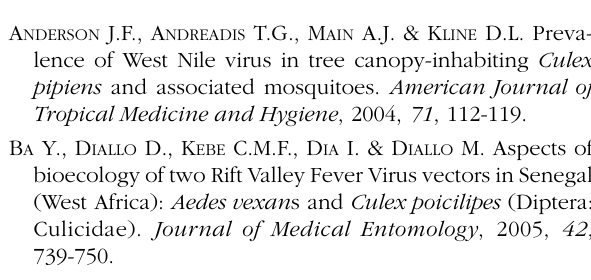
Table ii. – Means number of mosquitoes collected by pigeon and chicken bait on the ground and canopy levels between September 27 and November 26, 2006, at Barkedji, Senegal. Means with different letters are significantly different at p =